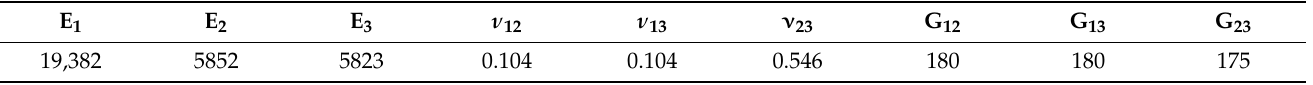
Figure 17. Displacement results (in mm) for the: ( a ) first column of tensor C; ( b ) second column of tensor C; ( c ) third column of tensor C; ( d ) fourth column of tensor C; and ( e ) sixth column of tensor C. Table 4. Global material properties obtained from the RVE